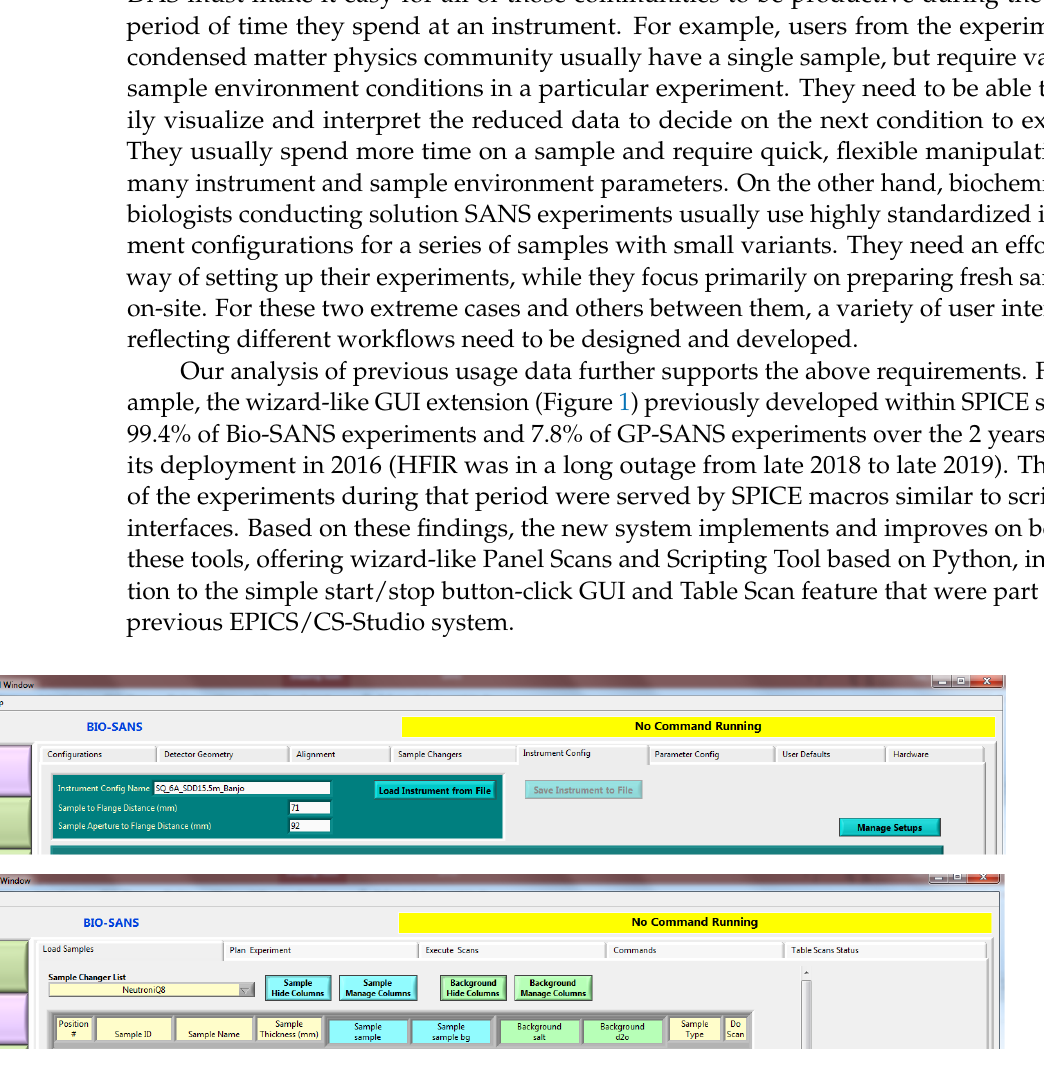
Figure 1. The Spectrometer Instrument Control Environment (SPICE) graphic user interface (GUI) extension with a wizard-like tool to set up scans for small-angle neutron scattering (SANS); highlighted in purple is the currently selected function group.